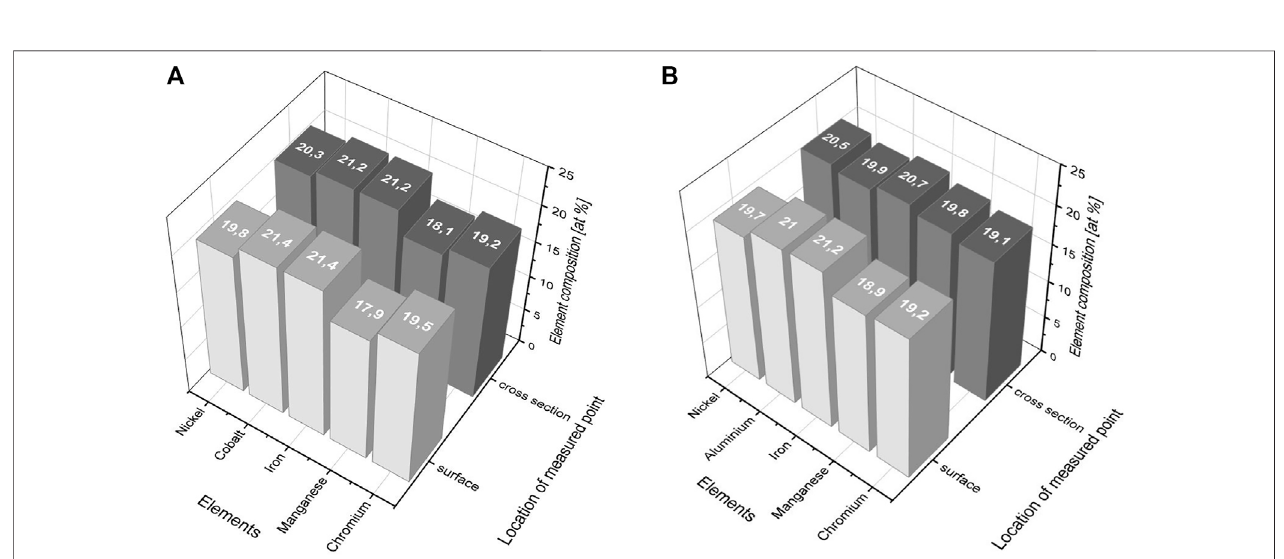
FIGURE 5 | Results of material composition analyses for Cantor alloy (A) and AlCrMnFeNi (B) .